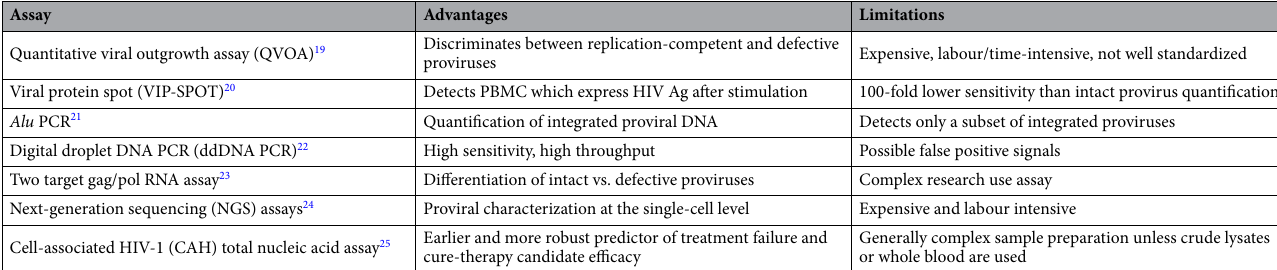
Table 1. Laboratory developed assays for monitoring of viral